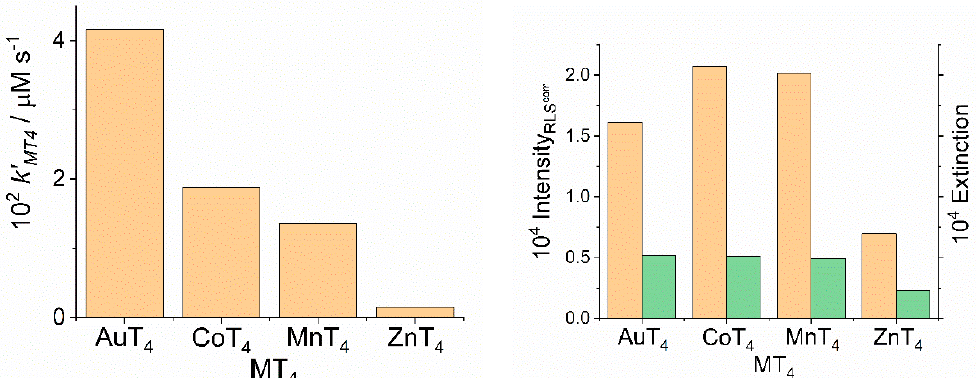
Figure 8. Bar plot of the rate constants k’ MT 4 ( μ M × s − 1 ) obtained as slope from Figure 7 ( left ) and the